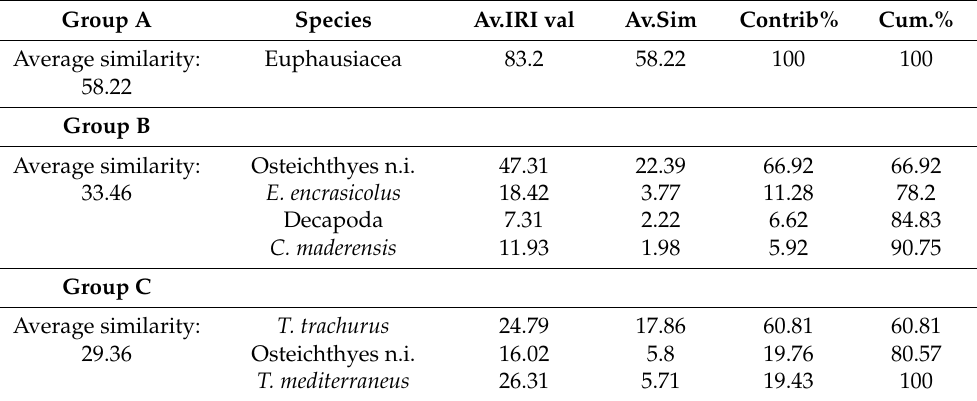
Table 9. Results of the SIMPER analysis conducted between European hake trophic groups collected between 2018 and 2020. The average similarity between cluster groups is reported. The percentage and cumulative contribution of typifying species within-group similarity of the identified hake trophic groups is shown. The table show results obtained for the trophic clusters A–C. Trophic cluster D = less than 2 size groups. Group A Species Av.IRI val Av.Sim Contrib%